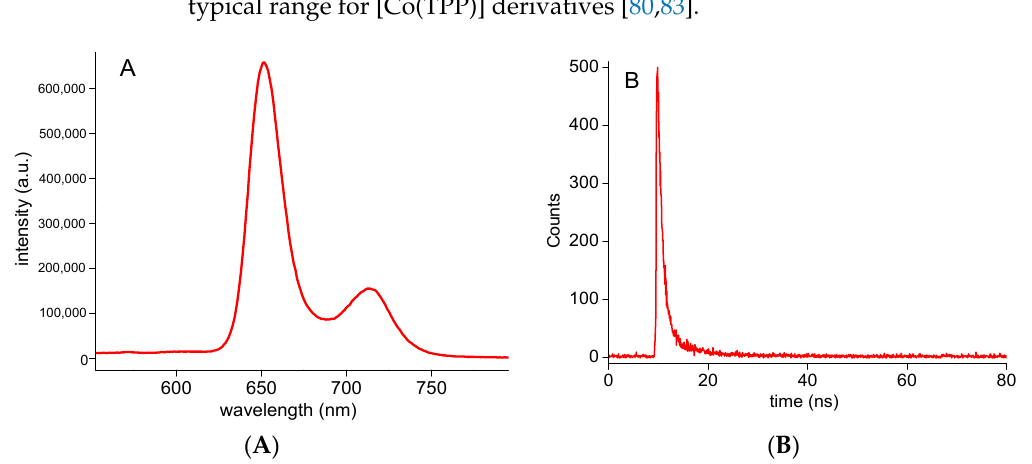
Figure 2. Emission spectrum of [Co(TMFPP)] in 10 − 6 M solutions in CH 2 Cl 2 at room temperature ( A ), excited at 405 nm; fluorescence decay profile ( B ).